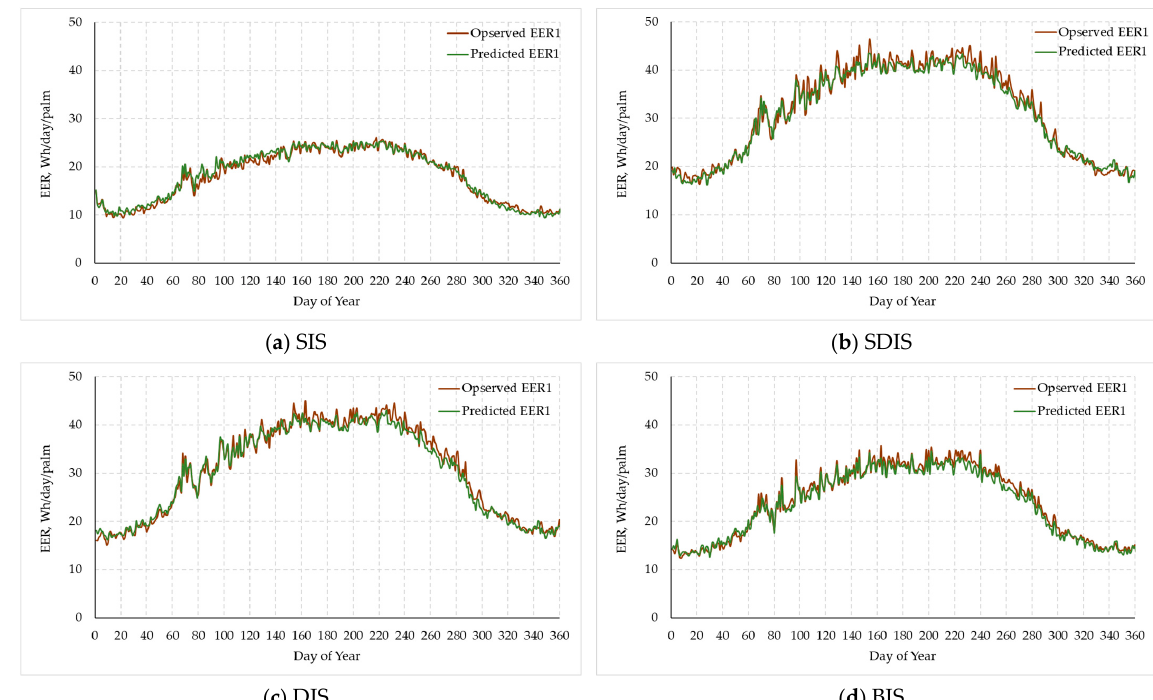
Figure 11. Observed vs. predicted values of electrical energy requirements (EER1) for optimum energy use under ( a ) subsurface irrigation system, ( b ) subsurface drip irrigation system, ( c ) drip irrigation system, and ( d ) bubbler irrigation